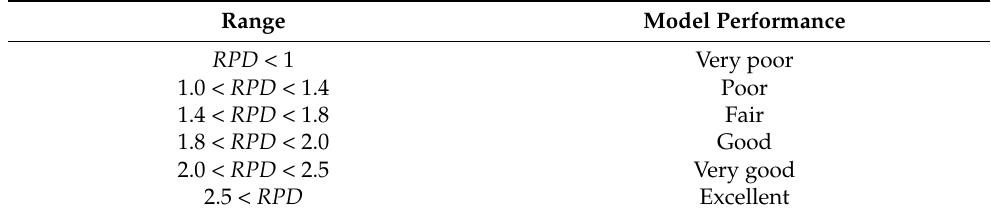
Table 1. The range of RPD for model